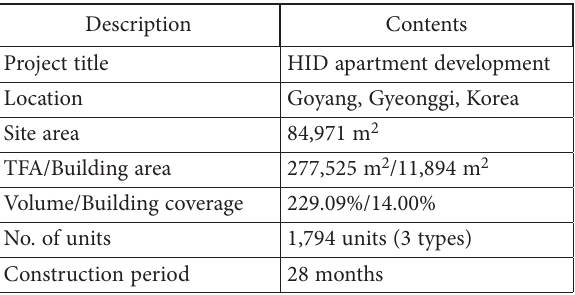
Table 1. Brief description of a case